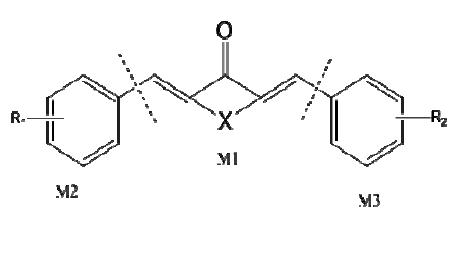
Figure 8. Molecular skeleton